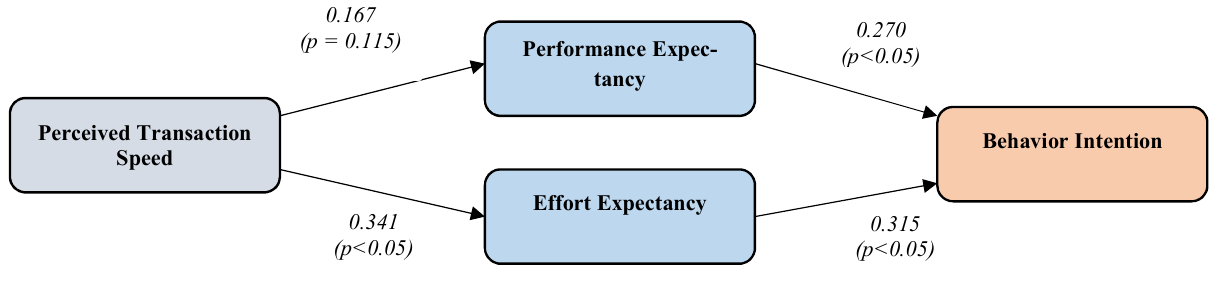
Fig. 4. Model estimation